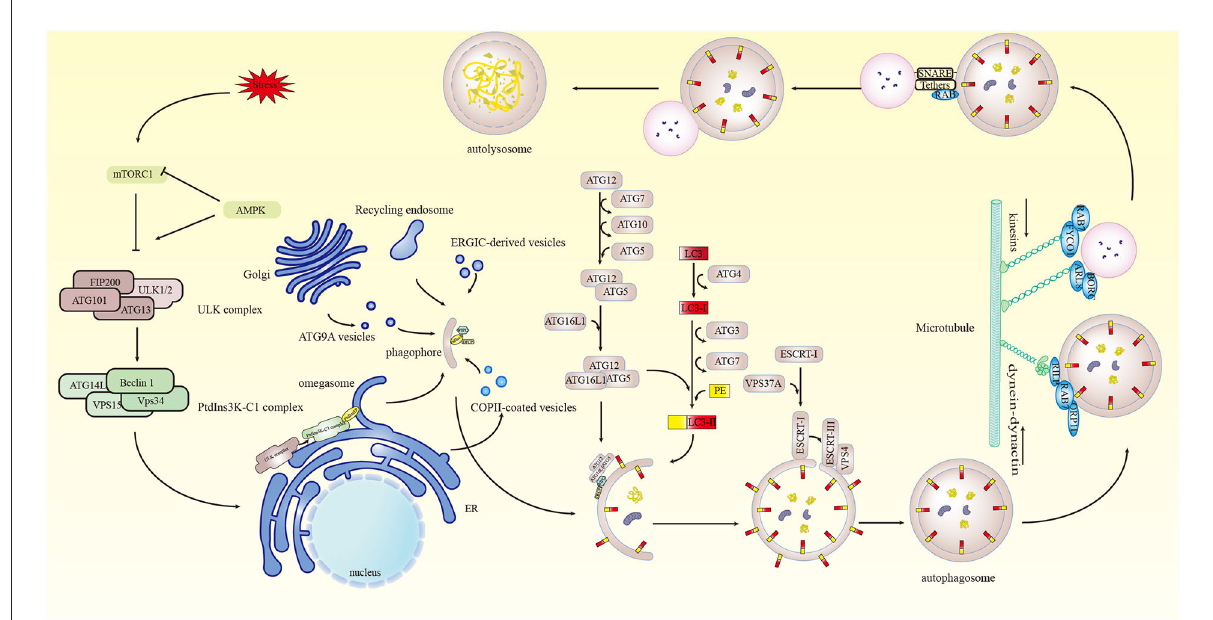
FIGURE1 Molecular process of autophagy. Stresses stimulate mTORC1, initiating autophagy. Under the action of mTORC1 and AMPK, ULK1 in the ULK complex is activated, which in turn activates VPS34 in PtdIns3K-C1, generating PtdIns3P in the omegasome. ATG9A vesicles, recycling endosomes, and COPII-coated vesicles are involved in phagophore generation and nucleation. PtdIns3P recruits DFCP1 and WIPI2 for phagophore nucleation and expansion. The ATG12 system and the LC3 system regulate phagophore elongation, and the ESCRT mechanism regulates phagophore sealing, forming autophagosomes. Microtubule-based motor kinesins, FYCO1-RAB7 and BORC-ARL8 complexes, and dynein-dynein motor complex with RAB7, RILP, and ORP1L participate in the fusion of autophagosomes with lysosomes. SNARE complexes, tethers, and Rab proteins act synergistically in the fusion of autophagosomes and lysosomes to form autophagolysosomes.